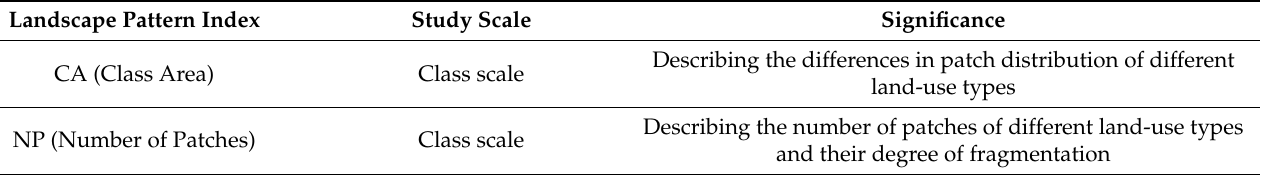
Table 3. Landscape pattern index in our